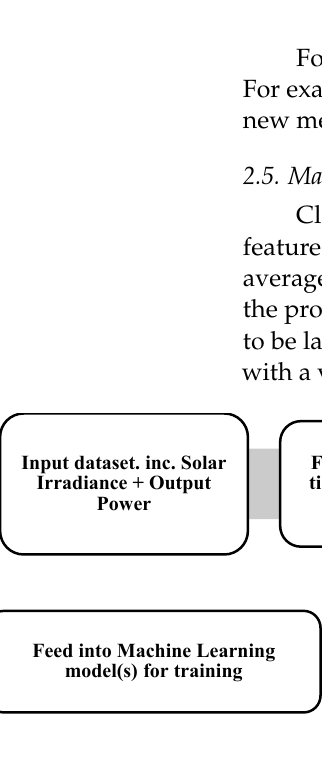
Figure 5. ML flowchart for PV fault identification.